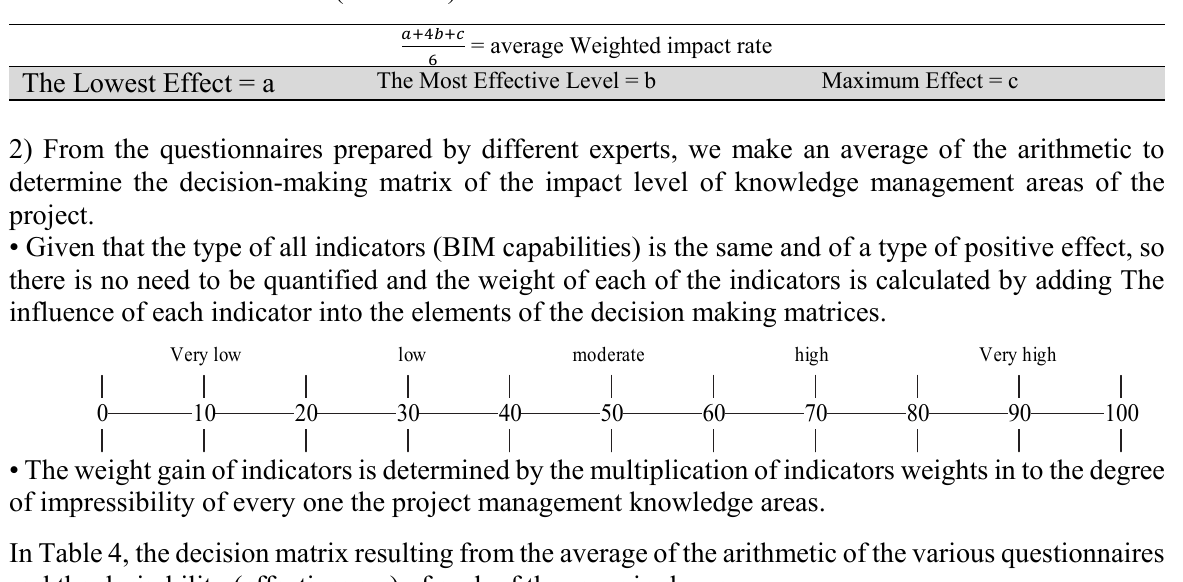
Decision making Average Uj integrated